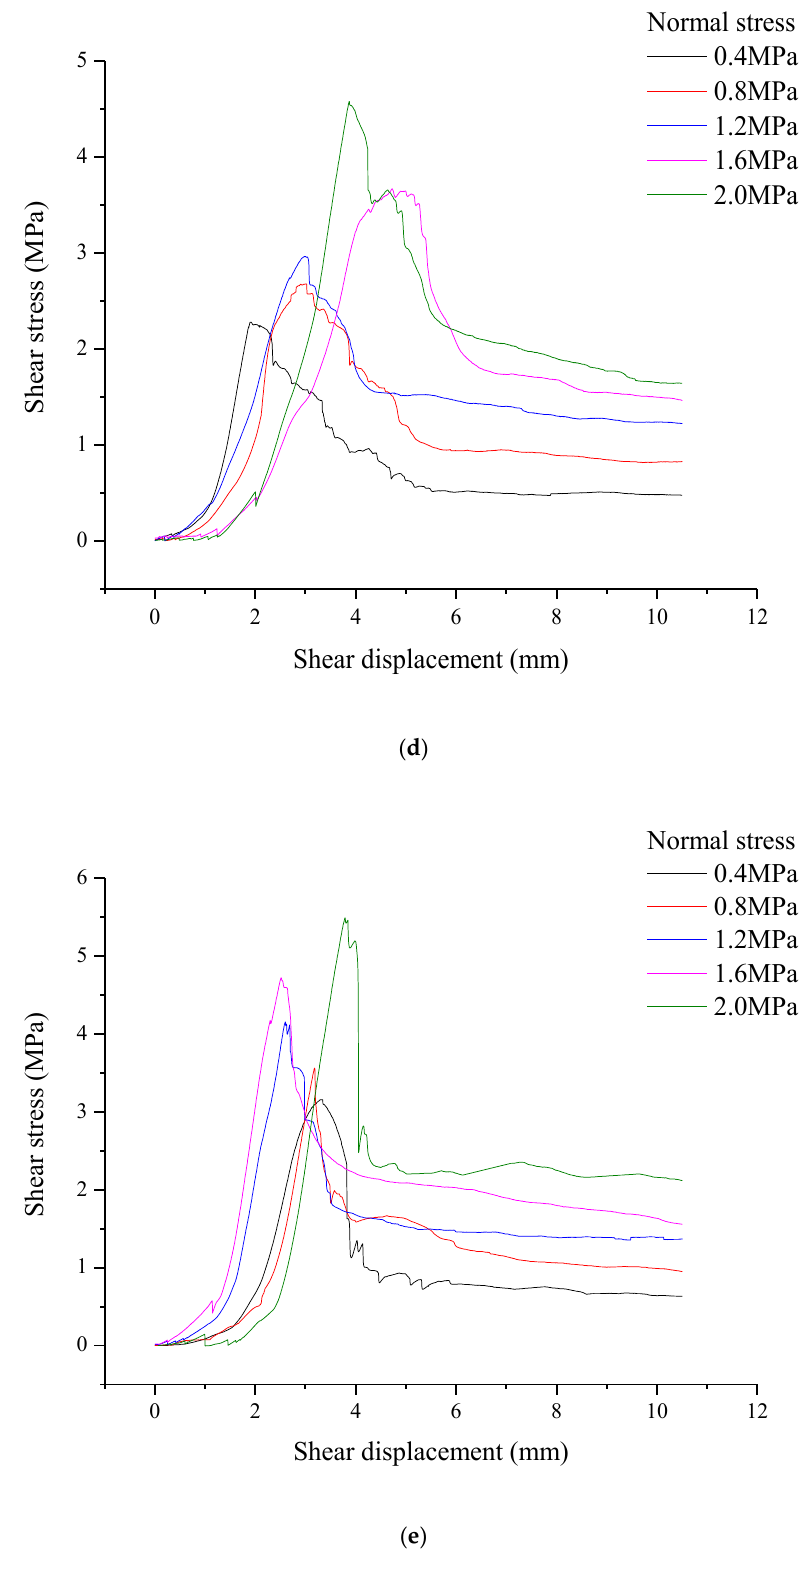
Figure 3. Shear stress–shear displacement curves of joints with different sawtooth angles: ( a ) Saw- tooth angle of 0°; ( b ) Sawtooth angle of 10°; ( c ) Sawtooth angle of 20°; ( d ) Sawtooth angle of 30°; ( e ) Sawtooth angle of 45°.